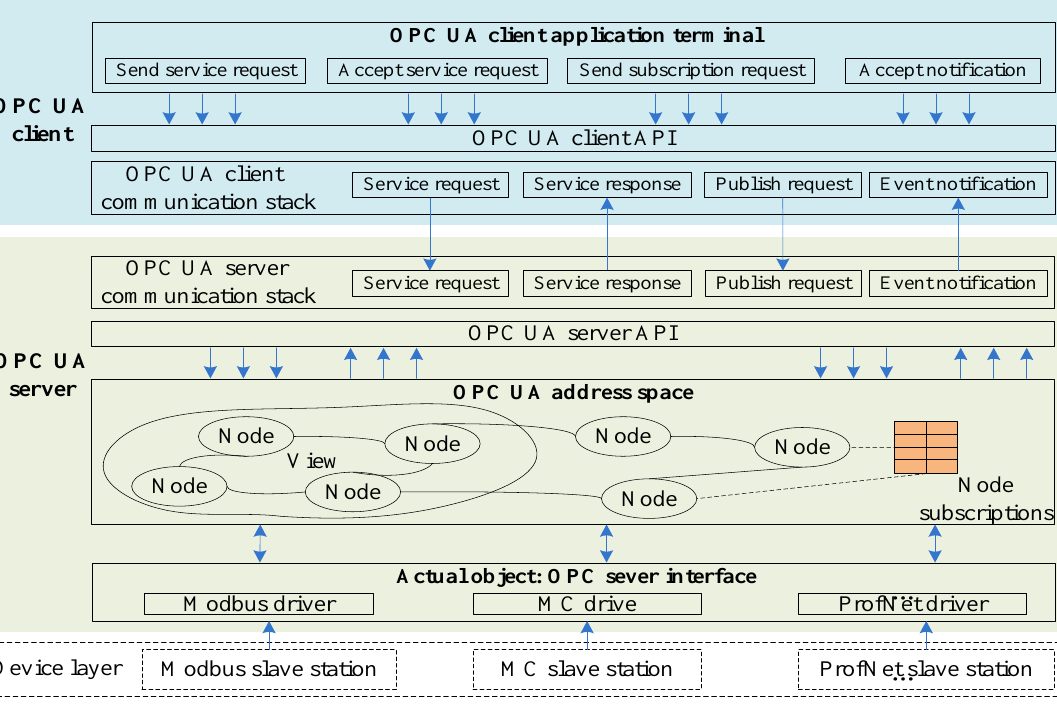
Figure 6. OPC UA server/client architecture.